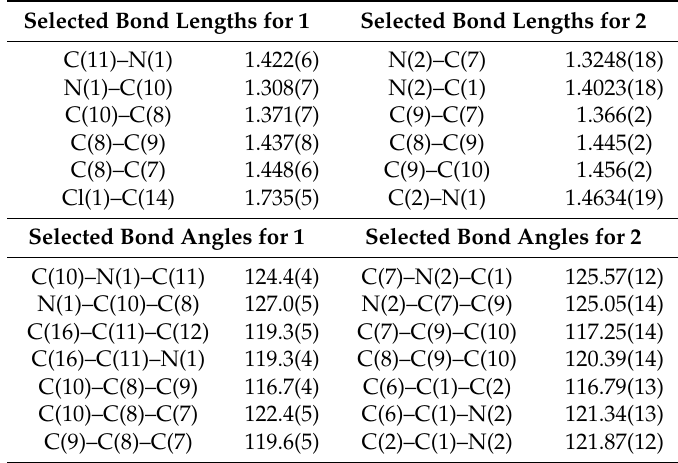
Figure 2. The packing arrangement in a unit cell of 1 and 2 . Table 1. Selected Bond Lengths (Å) and Bond Angles ( ˝ ) for 1 and 2